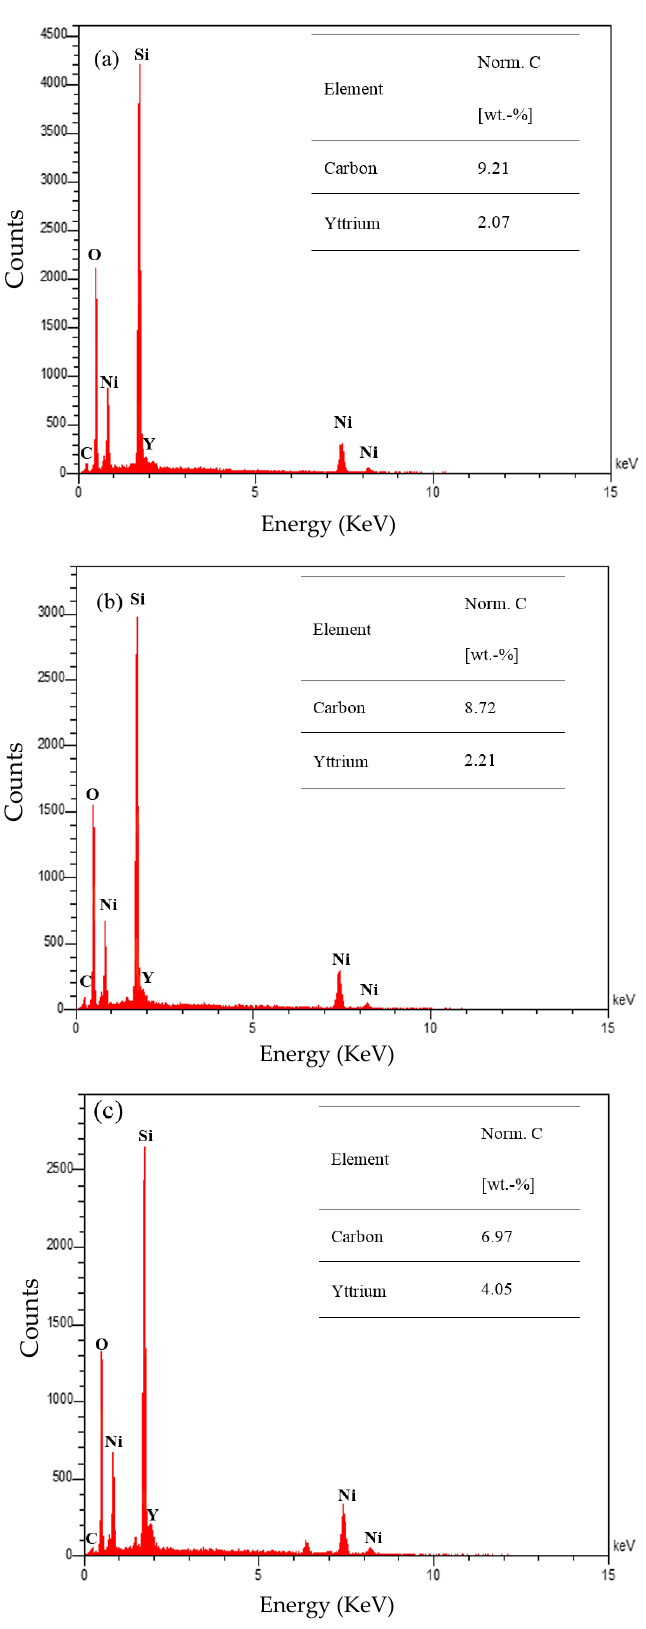
Figure 6. EDX of used ( a ) 20Ni-2.5Y/SBA-16; ( b ) 20Ni-3.7Y/SBA-16 and ( c ) 20Ni-7.4Y/SBA-16 oxygen carriers after 16 redox cycles at 650 °C.